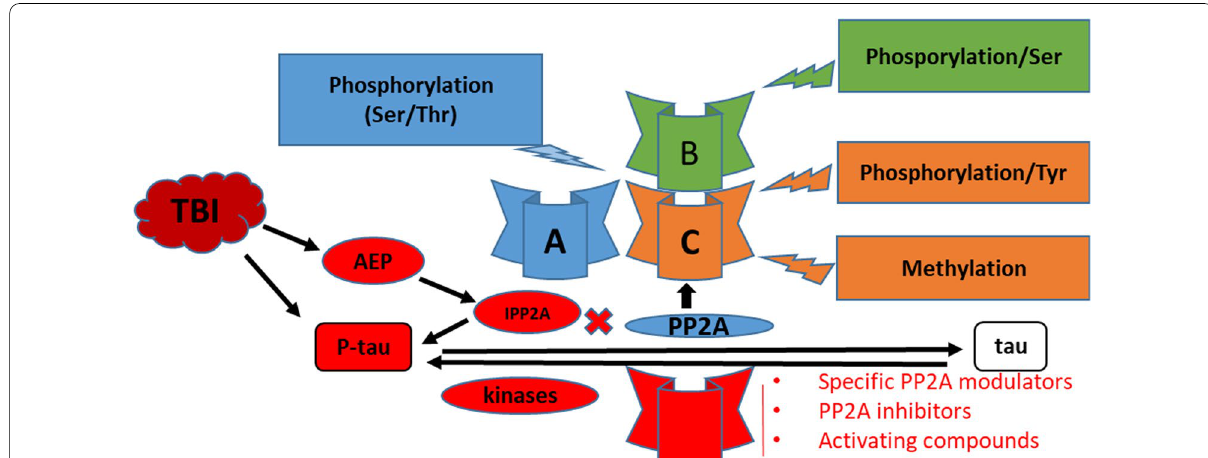
Fig. 1 Mechanism of PP2A tau modulation in TBI. Interaction of PP2A subunits with a variety of cellular proteins, and binding of specific PP2A inhibitors and modulatory proteins to the catalytic subunit, all combine to modulate PP2A catalytic activity and ensure PP2A isoform-specific targeting and substrate specificity. Specific modulatory proteins also critically regulate PP2A biogenesis, and many compounds, like sodium selenite, ferulic acid, are known to enhance PP2A catalytic